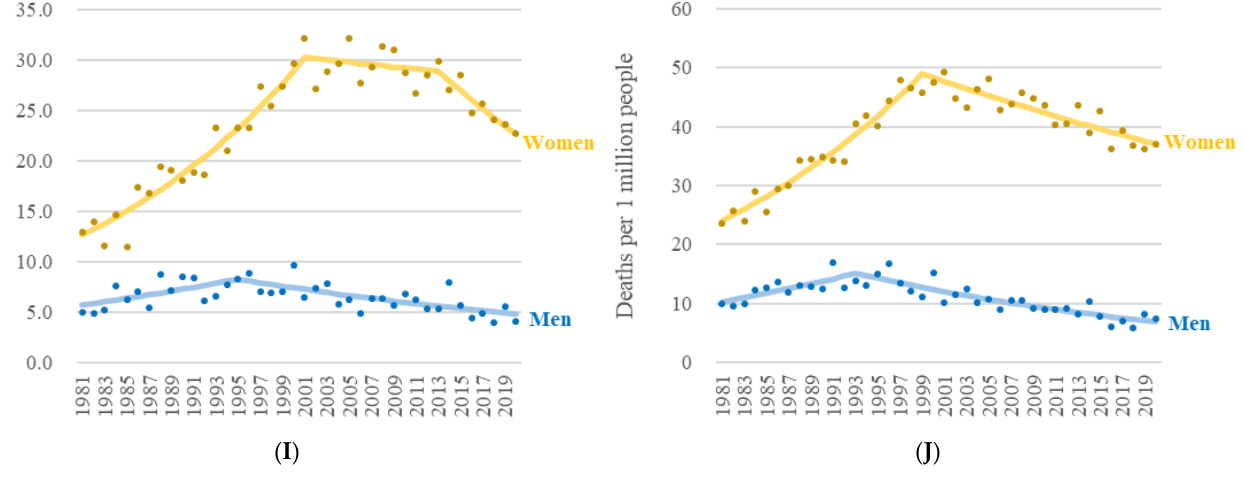
Figure 1. Age-standardized mortality rate of systemic sclerosis according to underlying causes of death (UCD) and multiple causes of death (MCD) stratified by sex in the United States, 1981–2020. ( A ) Overall, UCD. ( B ) Overall, MCD. ( C ) Age 0–44, UCD. ( D ) Age 0–44, MCD. ( E ) Age 45–64,